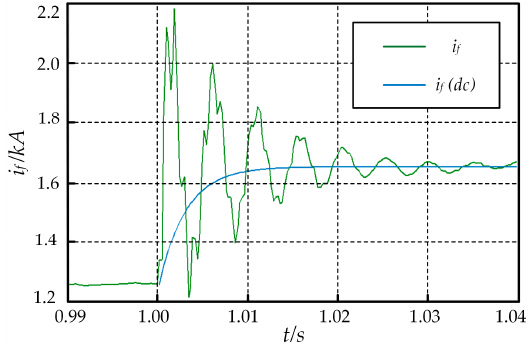
Figure 4. Schematic diagram of i f .